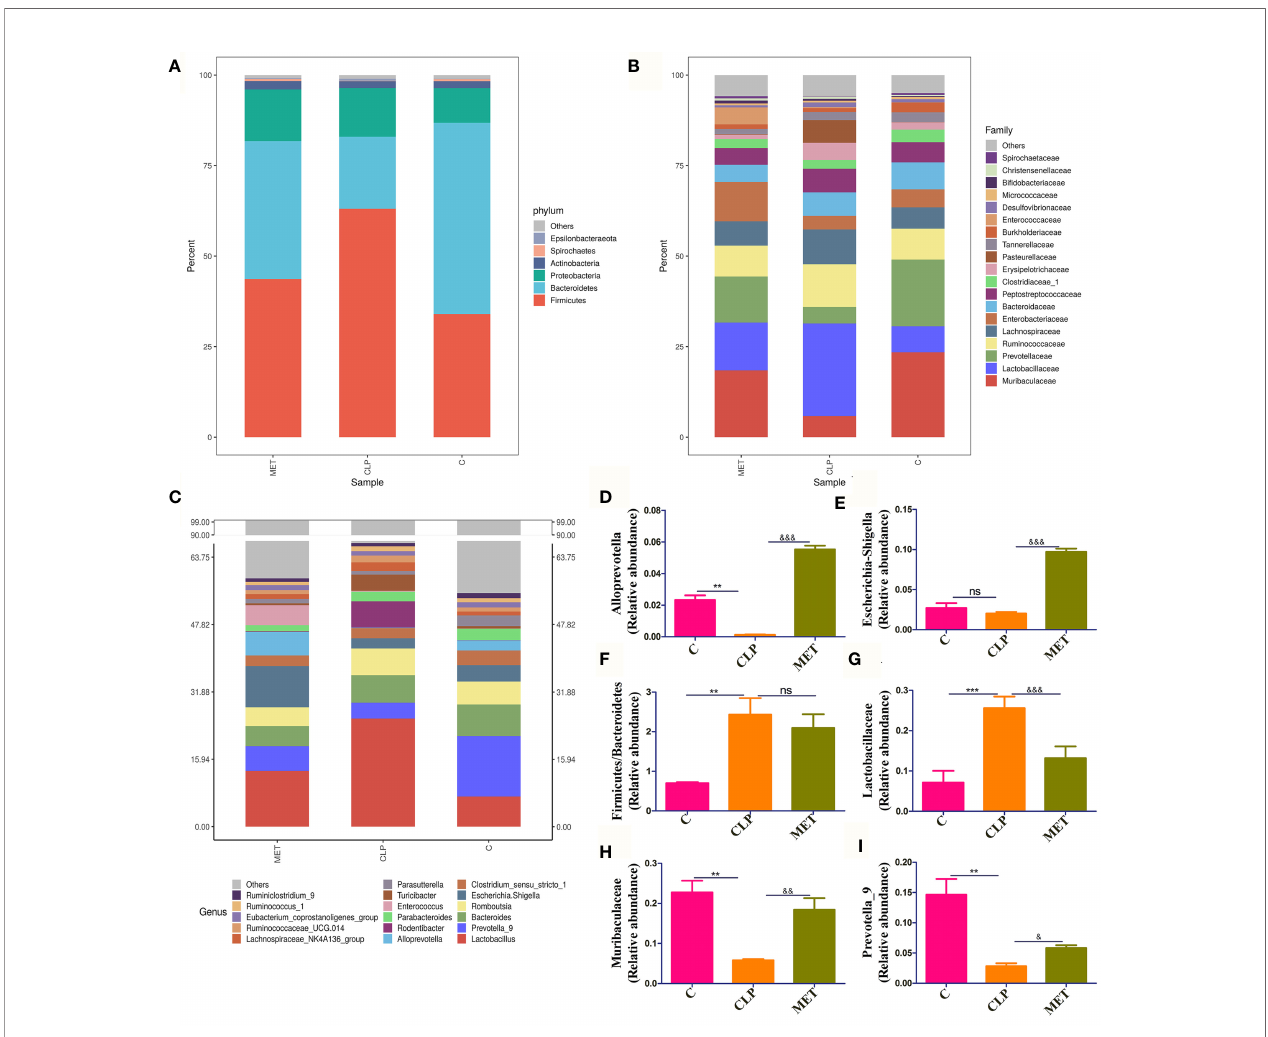
FIGURE 3 | The bene fi cial effect of metformin on gut microbiota in septic rats. (A – C) The gut microbiota at Phylum, Family, and Genus levels showed the difference among the C, CLP, and MET groups. (D – I) The speci fi c gut microbiota abundance varied among the groups, such as the relative abundance of Alloprevotella , Escherichia_Shigella , Prevotella _9 and Muribaculaceae were decreased in the CLP group compared to the C group, but increased in the MET group compared to the CLP group rats; while ratio of Firmicutes / Bacteroidetes and Lactobacillus were increased in the CLP group compared to the C group, and decreased in the MET group.*: CLP vs C group; & MET vs CLP group. & P<0.05; **, && P<0.01; *** , &&& P<0.001; ns, not signi fi cant ( n =